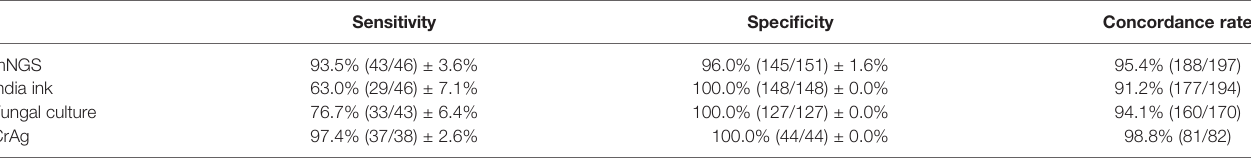
TABLE 2 | Comparison among mNGS and traditional tests for the diagnosis of cryptococcal CNS